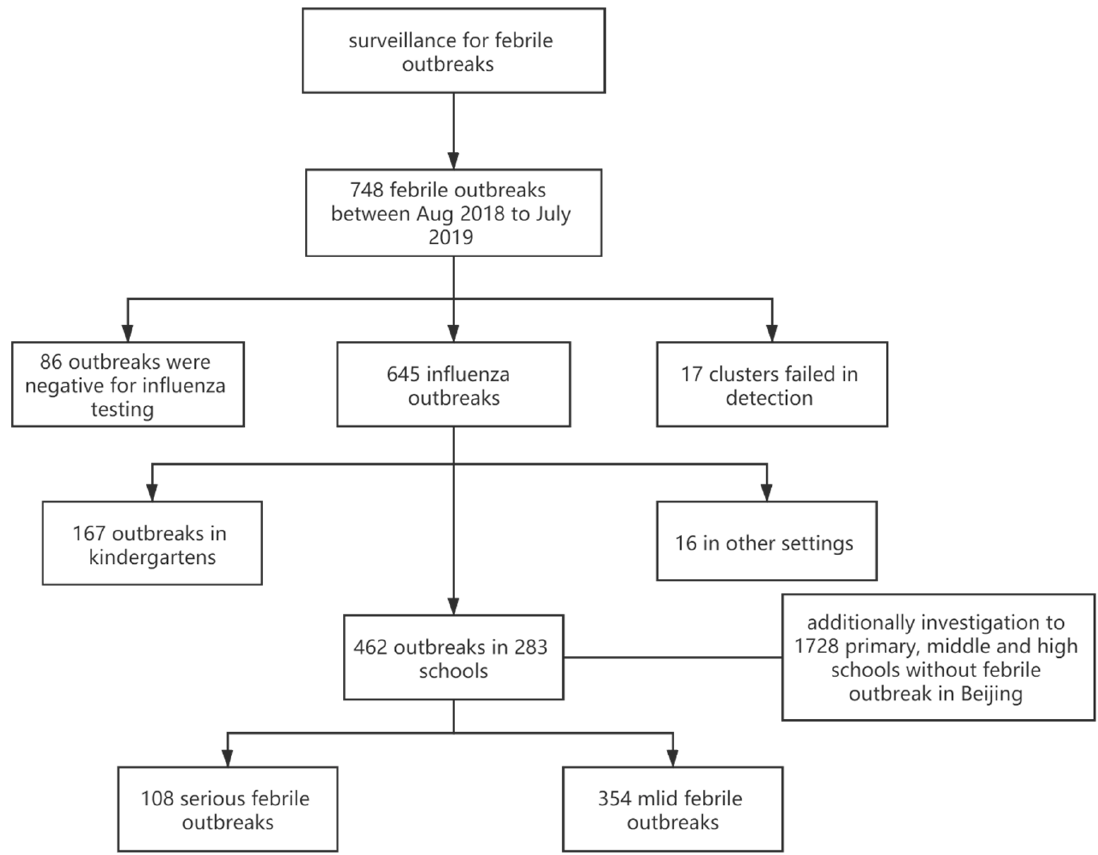
Figure 1. Flow chart and basic information of febrile outbreaks identified in Beijing from August 2018 to July 2019.